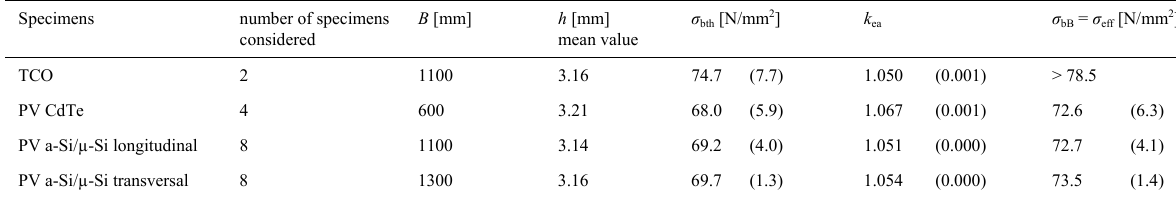
Table 7: Calculation of the bending strength in the edge ablated area (mean values, standard deviation in brackets).